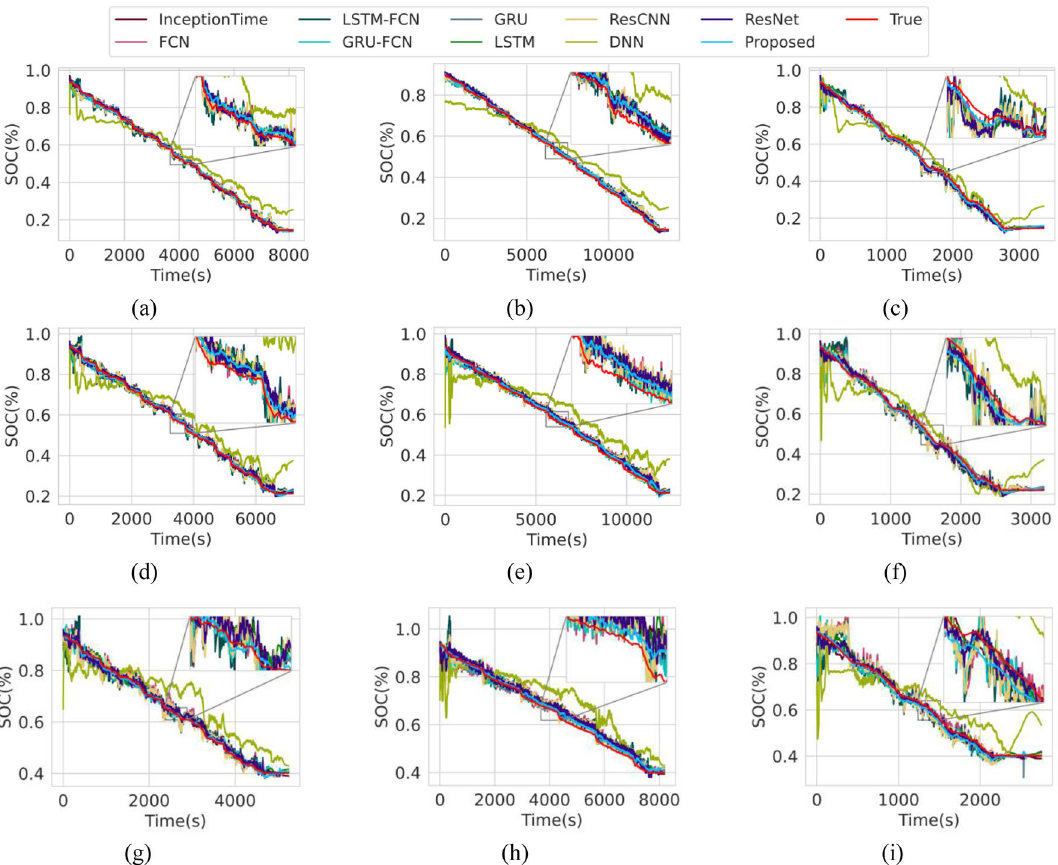
Figure 3. SOC estimation at below zero ambient temperatures. ( a ) LA92 drive cycle at 0 °C. ( b ) UDDS drive cycle at 0 °C. ( c ) US06 drive cycle at 0 °C. ( d ) LA92 drive cycle at − 10 °C. ( e ) UDDS drive cycle at − 10 °C. ( f )